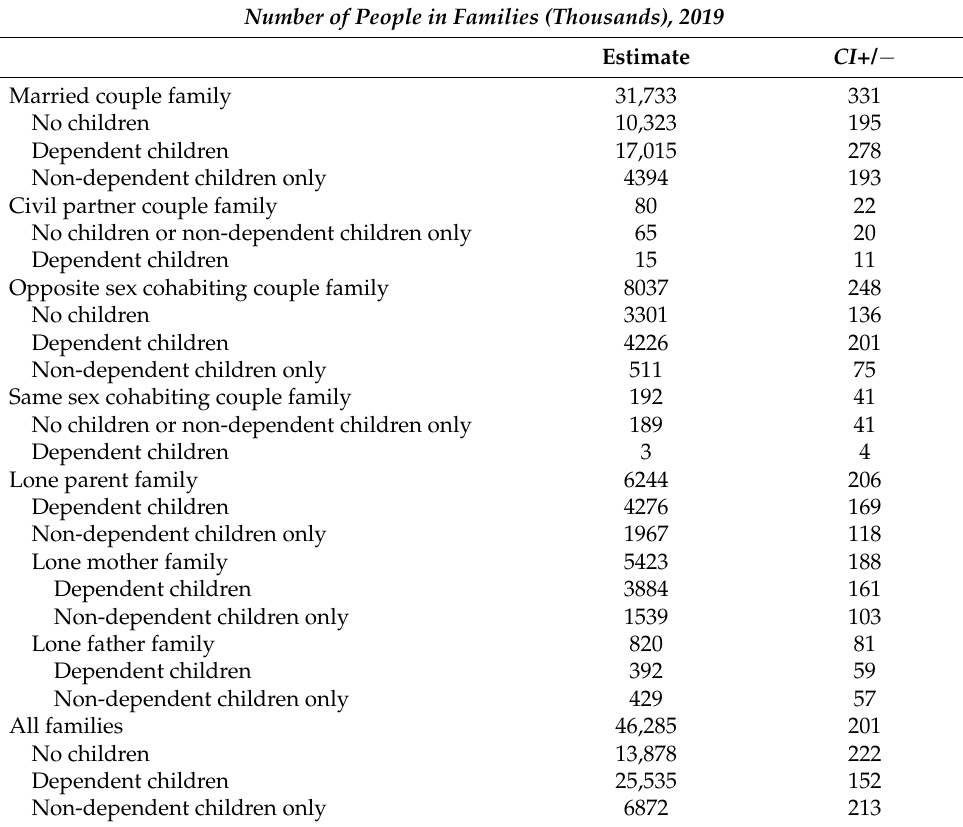
Table 1. Families by family type and presence of children, England,